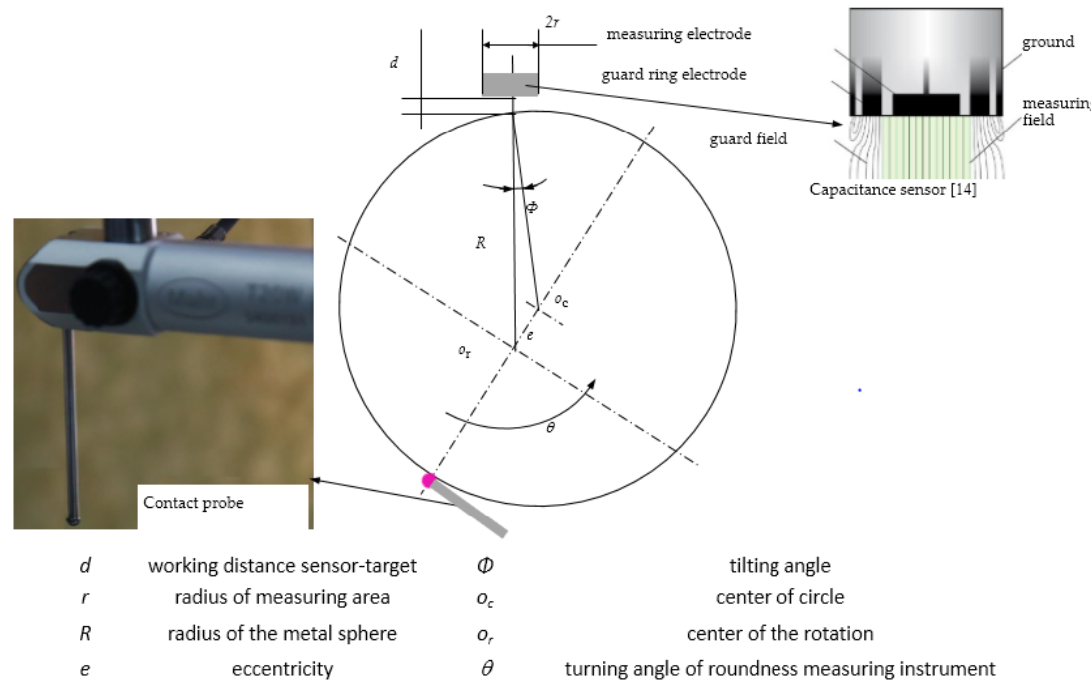
Figure 5. Eccentric sphere synchronization measurement.